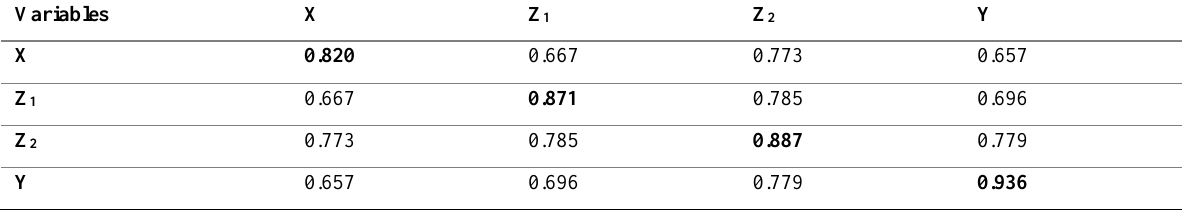
Table 3: Discriminant Validity Test Using AVE Roots